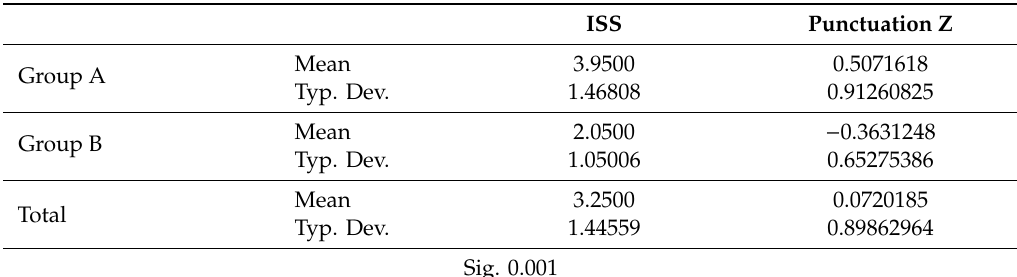
Table 18. E ff ect of the learning group in the Individual Subjective Sensation (ISS).